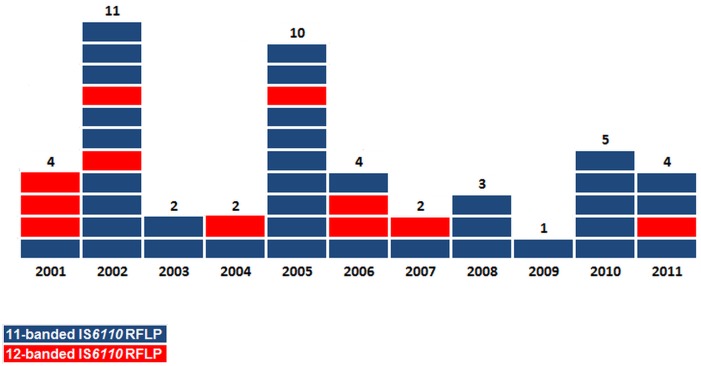
Temporal distribution of the 48 Haarlem3 MDR-TB outbreak cases, 2001–2011.